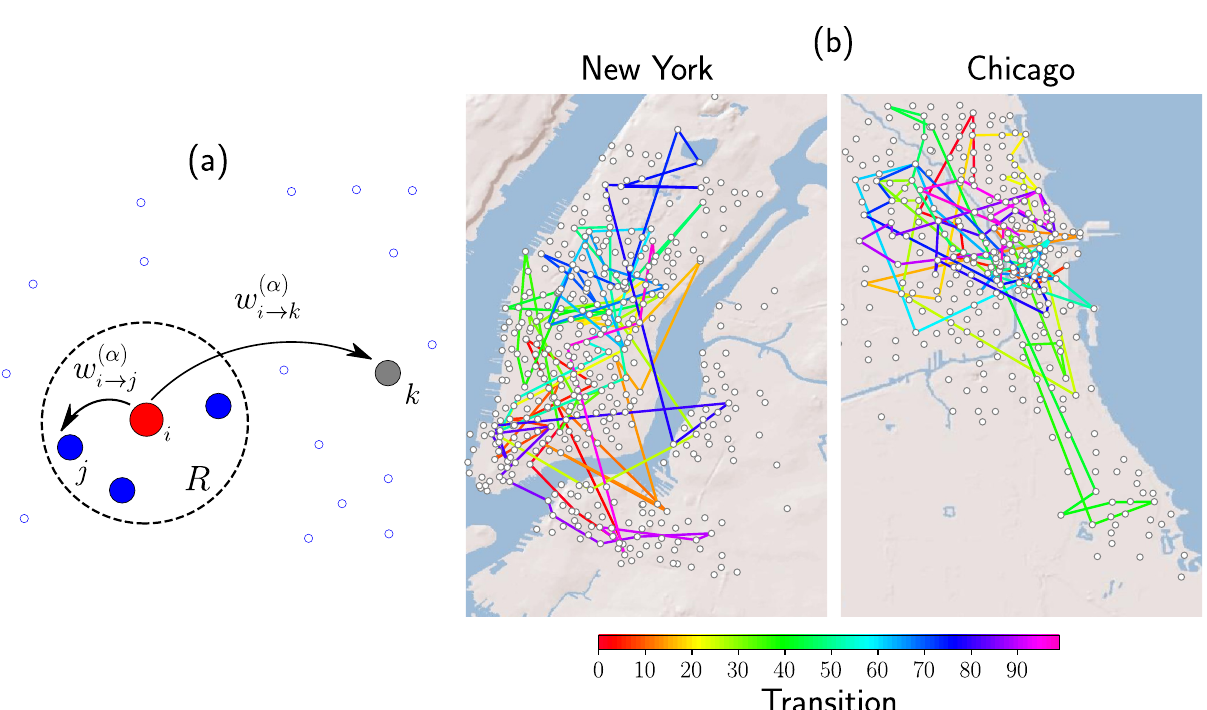
Fig 5. A schematic illustration of the random walk strategy as defined in Eq (16). In (a) we depict locations on the plane (represented by circles); the ð R Þ , which is a constant, to a site j inside a probability to go from location i to a different site is determined by two types of transition probabilities: w ð a Þ i ! j circular region of radius R centered in the location i and w ð a Þ ð R Þ , for a displacement to the site k outside the circle of radius R , that considers long-range i ! k transitions with a power-law decay proportional to d (cid:0) a , where d ik is the distance between sites i and k . In (b) we present Monte Carlo simulations of a ik discrete-time random walker that visits the stations in BSS in the cities of Chicago and New York following the random strategy defined by the transition probabilities in Eq (16). The information of the values N , R and α used in each system is reported in Table 1. The total number of transitions between stations in each simulation is t = 100 and we assign a colored line to each of the displacements. The scale in the color bar represents the discrete time t at which each transition occur. The maps were drawn from base maps of satellite imagery (Source: http://server.arcgisonline.com/ArcGIS/rest/ services/World_Shaded_Relief/MapServer) and the Matplotlib Basemap package (https://pypi.python.org/pypi/basemap/1.0.7).